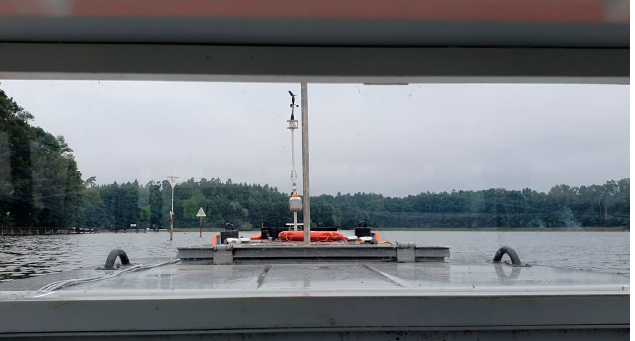
Figure 5. Course keeping trial parallel to the leading lights, view from the bridge of the ship model. The trial of steady course keeping parallel the leading lights was carried out with clockwise rotational speed of RC2 equal to 300 RPM. The stern rudder set 8°–10° to portside was used to compensate the RC generated yawing moment. The trajectory of the model (point at amidships) plotted during the trial is presented in Figure 6.